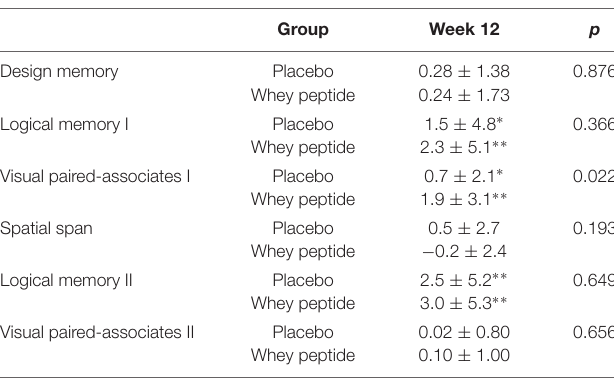
TABLE 2 | Changes in Wechsler memory scale-revised (WMS-R)